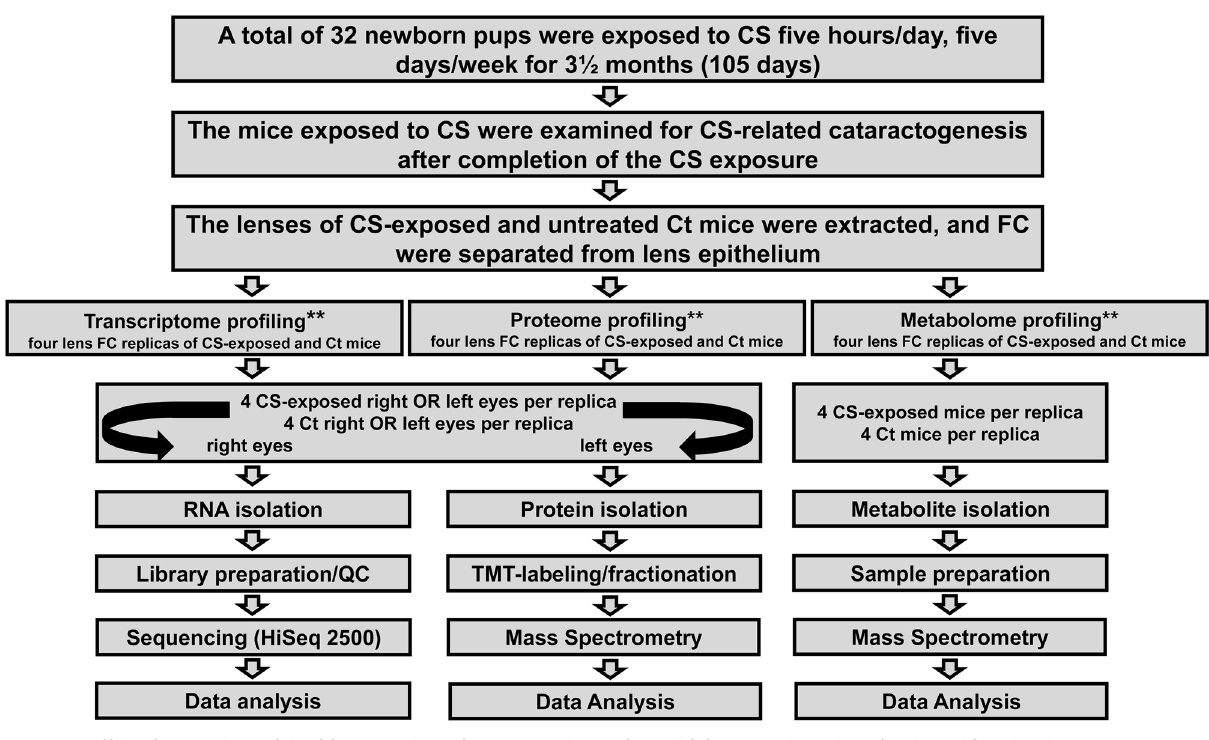
Figure 1. Illustration of the work flow adopted to investigate the effects of cigarette smoke (CS) on mouse lens fiber cells (FC) through a multi OMIC (transcriptome, proteome, and metabolome) approach. A total of 32 newborn mice were exposed to CS in a smoke chamber for 5 hours/day, 5 days/week for a total of 3½ months (105 days). The mice exposed to CS exposure were examined for CS-related cataractogenesis. The CS-exposed and age-matched, untreated control (Ct) mice were euthanized, lenses were extracted, lens FC were separated from the epithelium and used for next-generation RNA sequencing-based transcriptome,